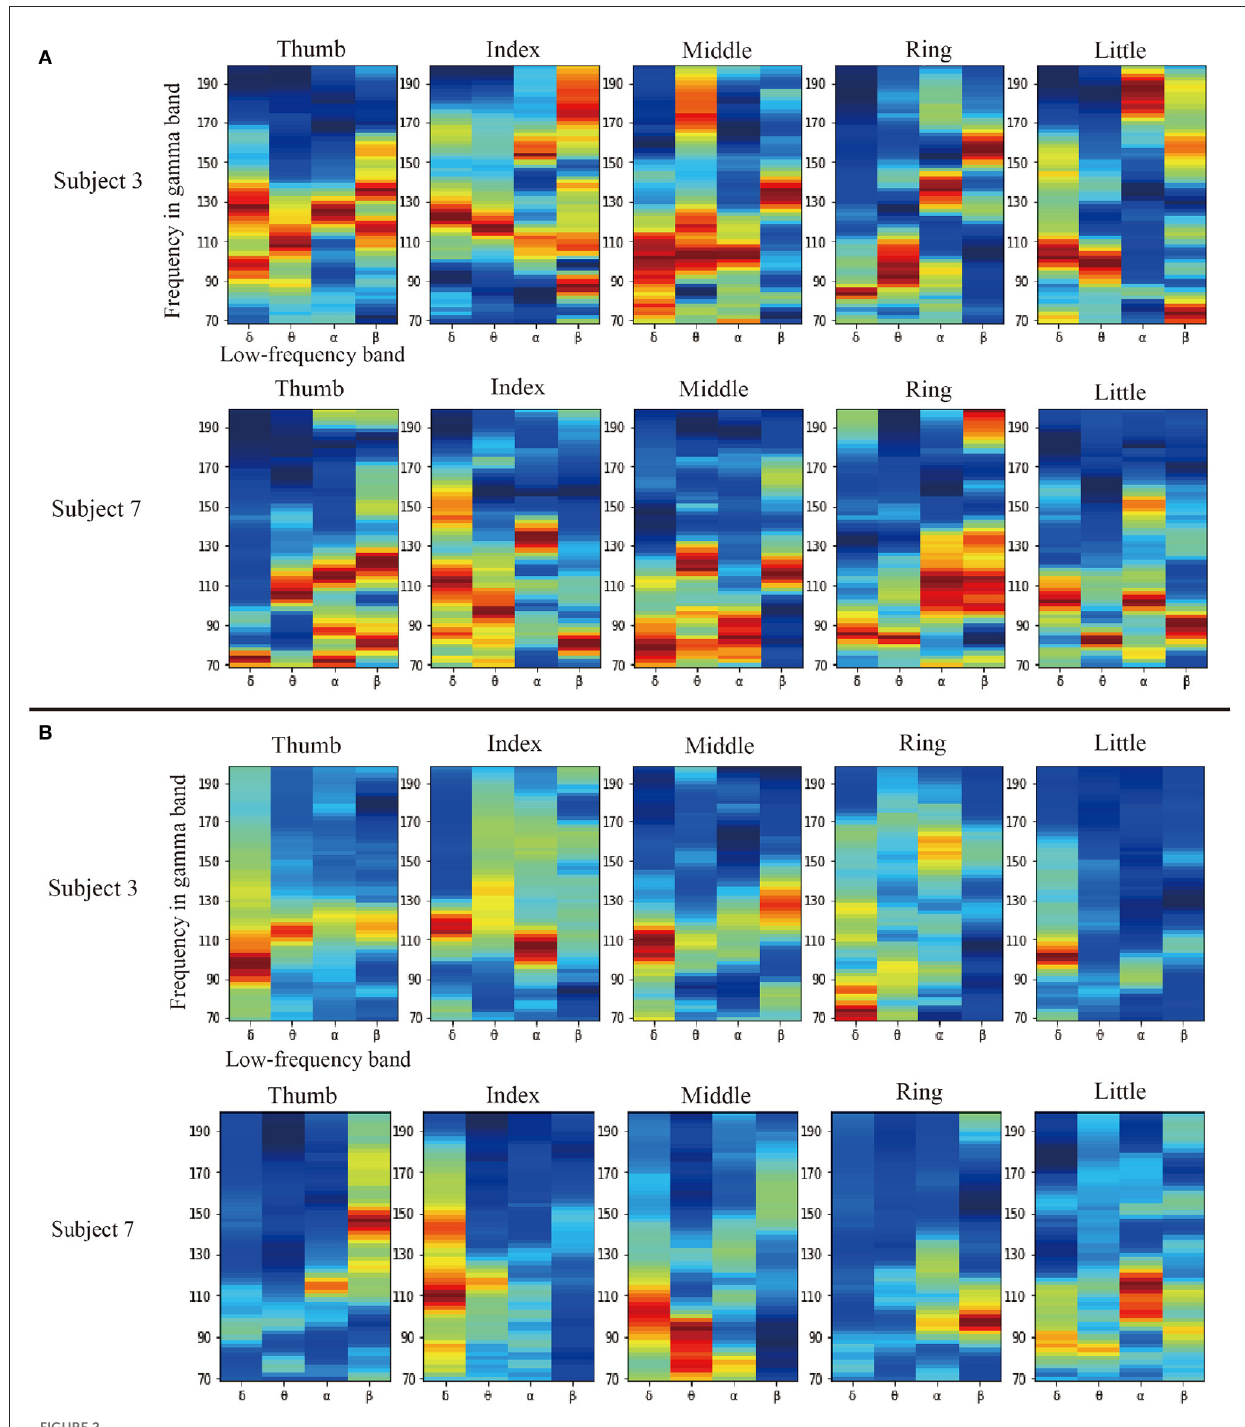
FIGURE2 Comparison diagram of filter weight on two subjects in the fingerflex dataset, (A, B) , are in motion and rest states, respectively. In each sub-graph, the vertical axis represents the high-frequency in the high-gamma band, and the horizontal axis represents the four low-frequency bands: delta, theta, alpha, and beta. There are four columns in (A, B) , and each column represents a subject. At the same time, we show the specific situation of each finger of the subject. There are five rows in (A, B) , and each row represents a